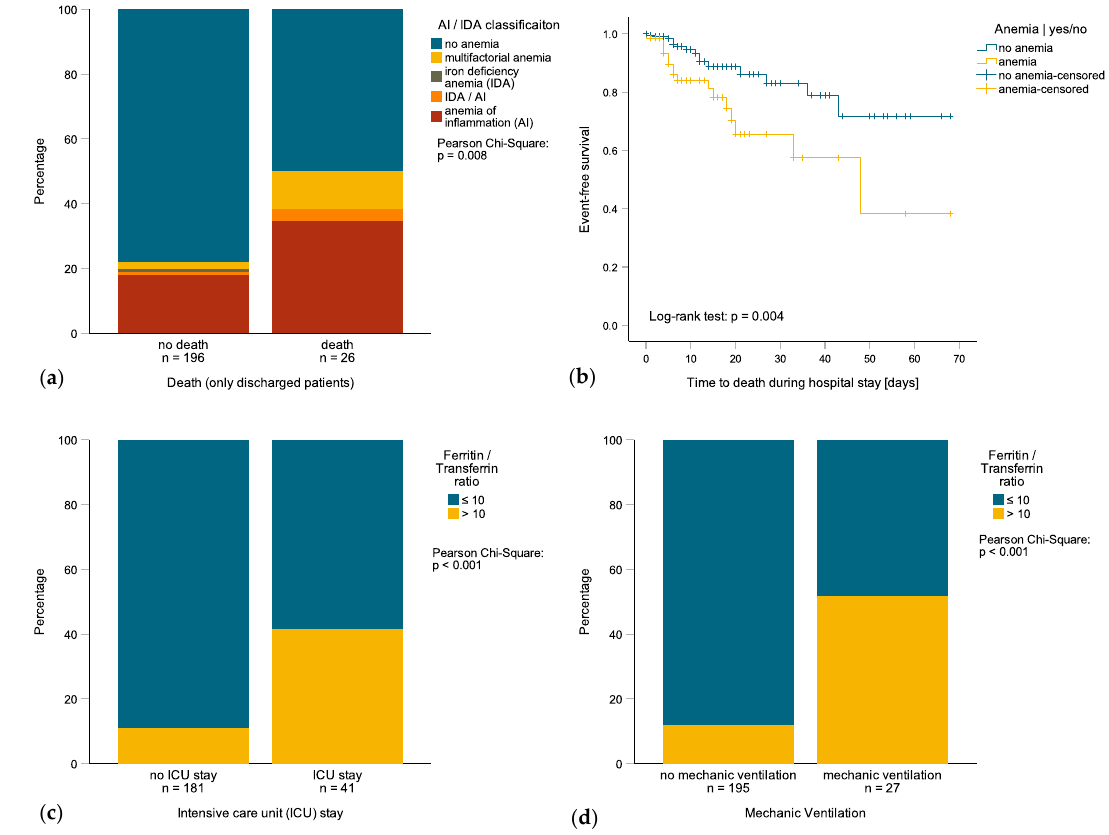
Figure 1. ( a ) prevalence of multifactorial anemia, anemia of inflammation (AI) and / or iron deficiency anemia (IDA) in patients who died or survived; ( b ) Kaplan–Meier survival curve of anemic and non-anemic patients (HR 2.678 (95%CI 1.335 – 5.376), p = 0.006); ( c ) prevalence of ferritin / transferrin ratio > 10 vs. ≤ 10 in patients with or without intensive care unit (ICU) admission; ( d ) Prevalence of ferritin / transferrin ratio > 10 vs. ≤ 10 in patients with or without mechanic